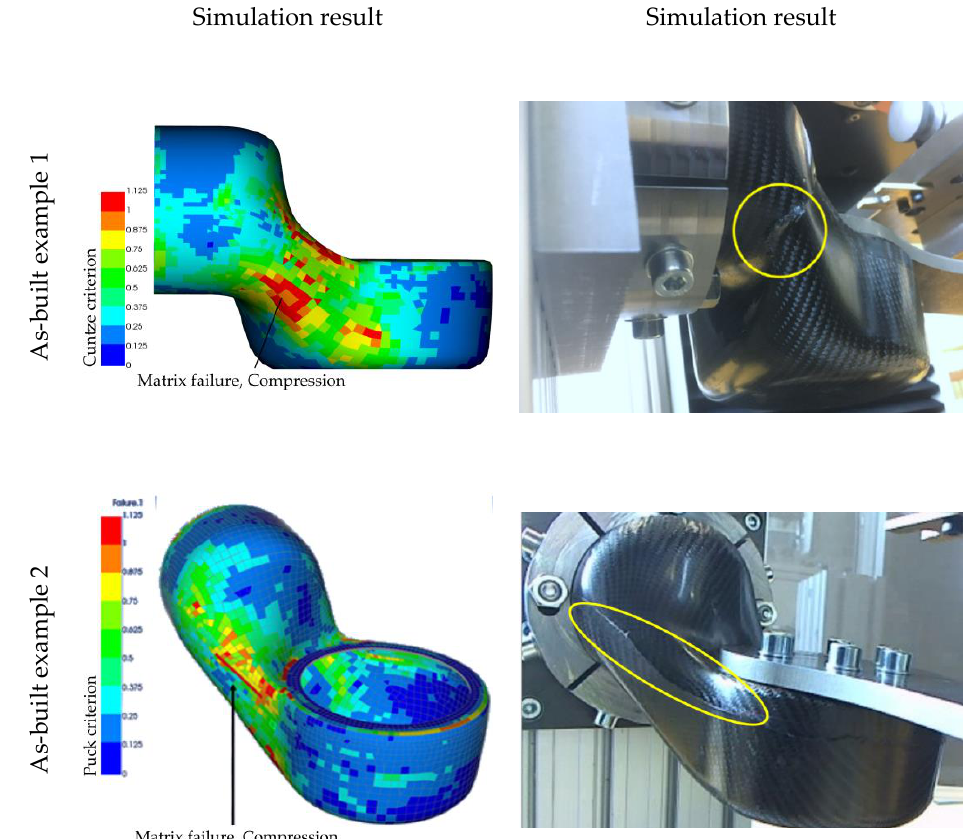
Figure 19. Results of the two-point bending simulation for as-built configurations.